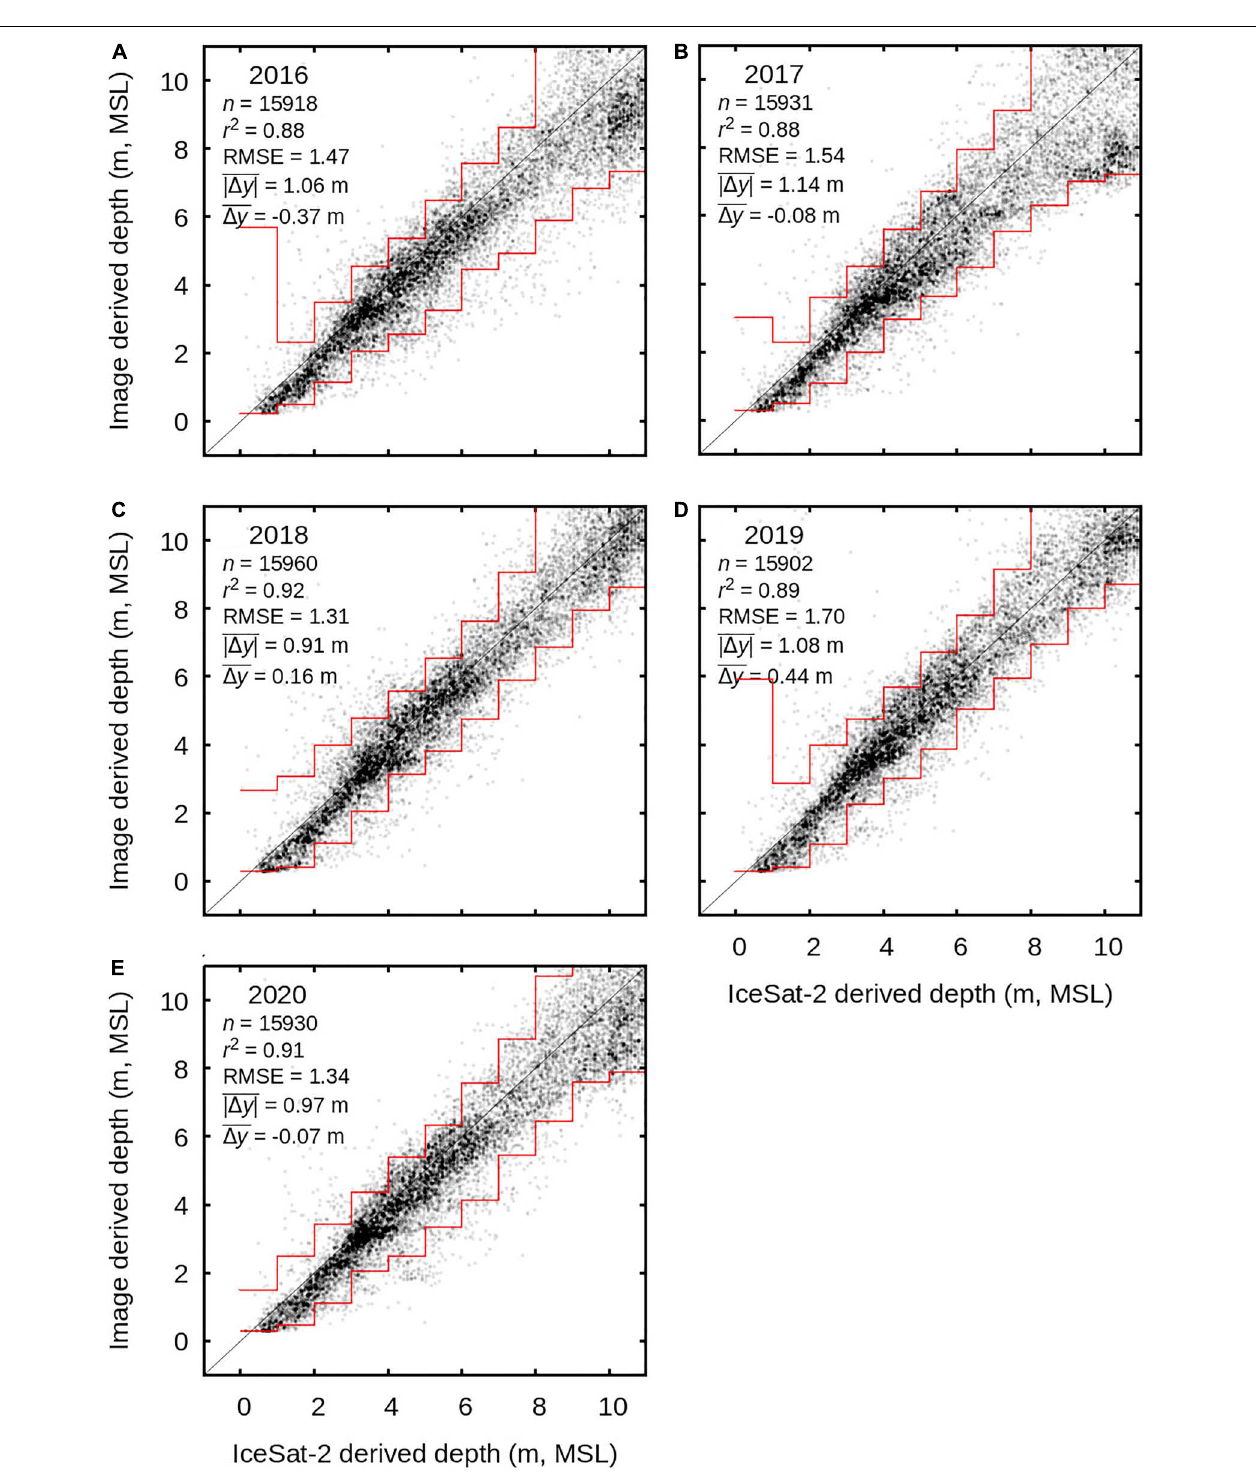
FIGURE 5 | ICESat-2 depth data compared to image derived year-median depths over the entire processed area. (A–E) show years 2016 to 2020. The ICESat-2 data spans 2018–2020 but was treated as a single data set and has been randomly subset to ensure even depth stratification from 0 to 15 m in 5 m bins (i.e., there are n /3 points in 0–5 m, 5–10 m, and 10–15 m). Statistics are calculated over 0–15 m. In each 1 m step 95% of the points lie between the red